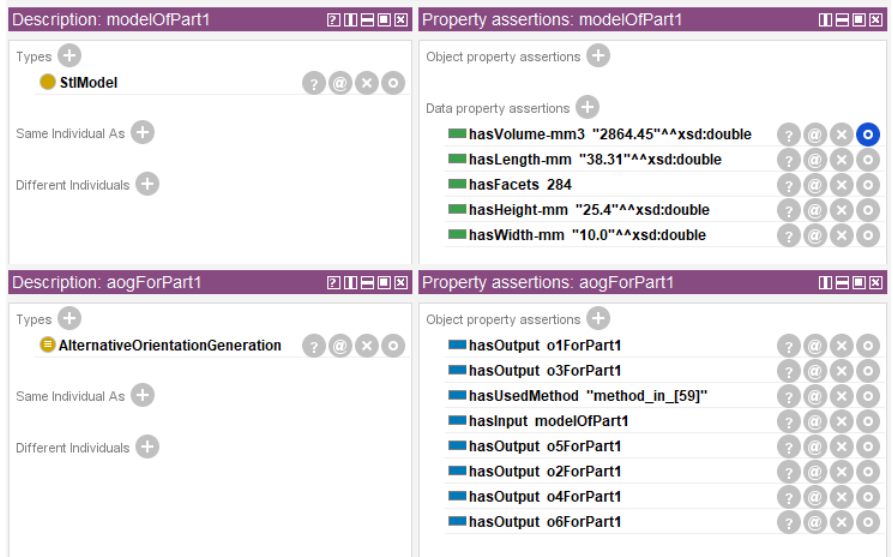
Figure 8. Instances and assertions generated after importing the STL model of Part